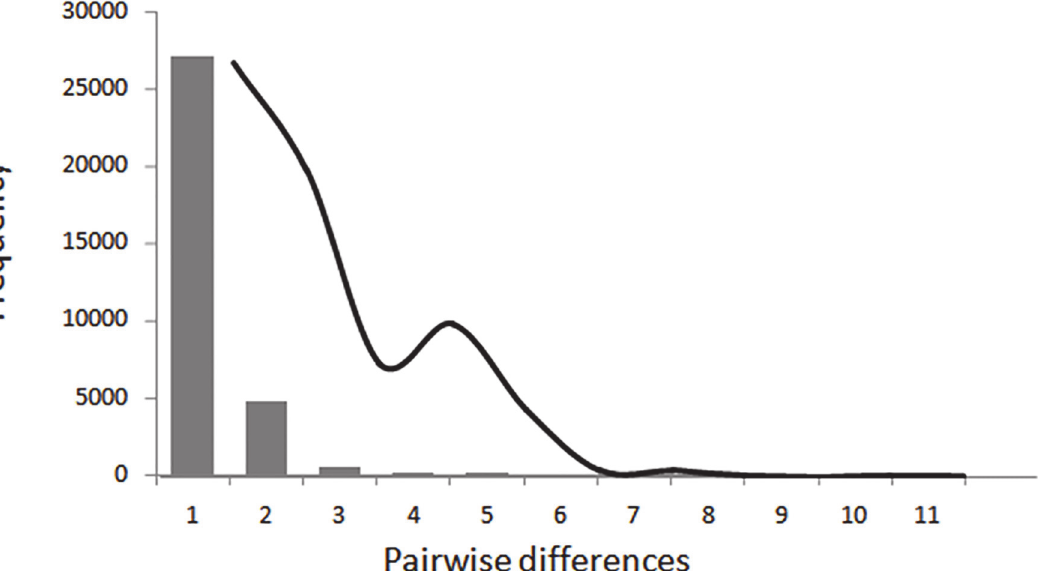
Fig 2. Pairwise mismatch distributions for overall sampled regions in the Atlantic and Indian Oceans. The observed values are represented in the in bars and the expected values in the line.